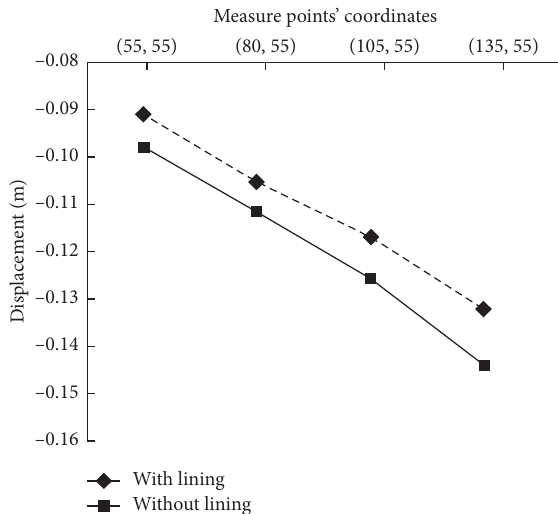
Figure 12: The measure points’ settlement curve with different support patterns.